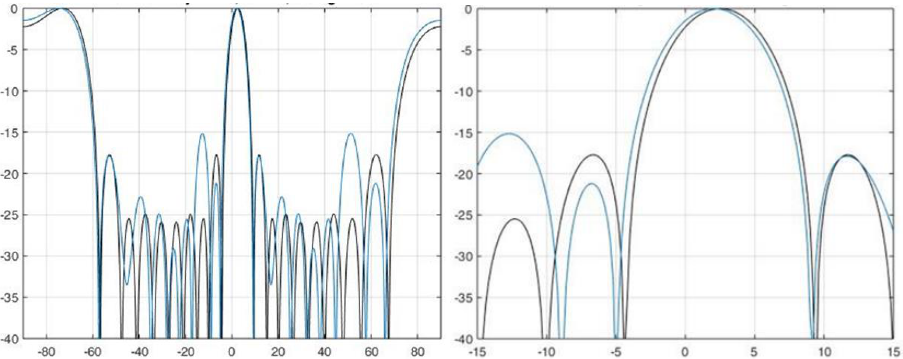
Fig. 3. Comparison of the antenna array factors for elementwise phasing (black line) and phasing of subarrays (blue